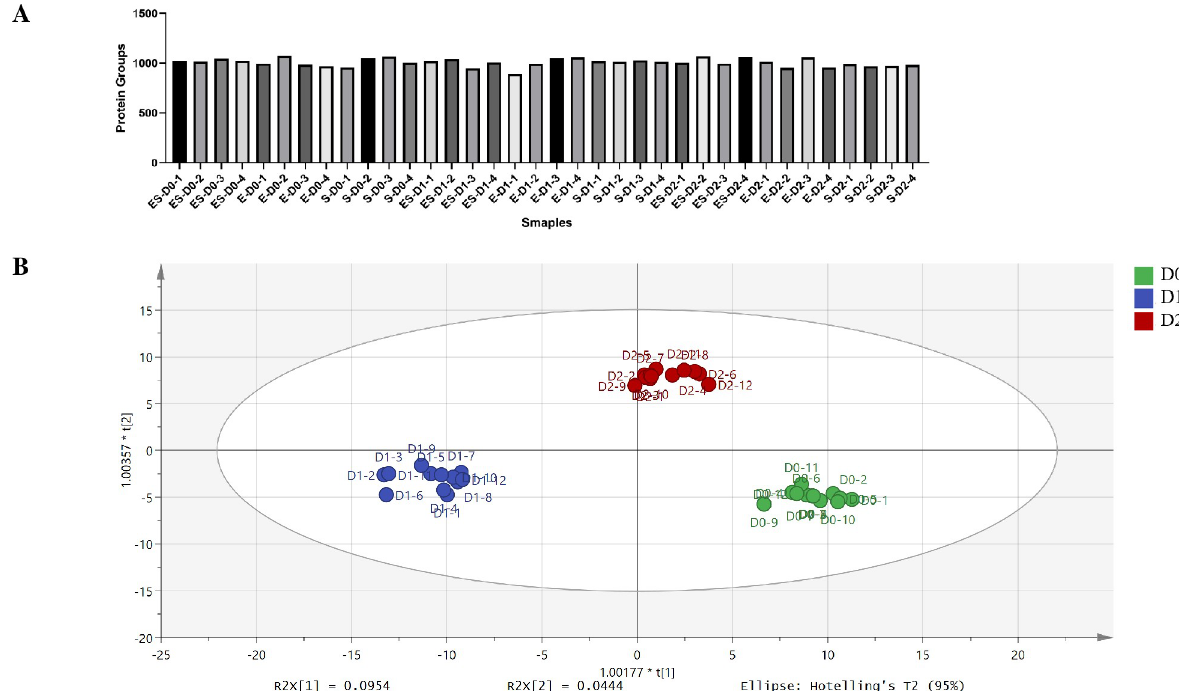
Fig 2. Proteomics analysis of the urine samples of three models. (A) Numbers of protein groups identified in each sample in this study. (B) OPLS-DA analysis of the 813 proteins from 36 urine samples of three models.